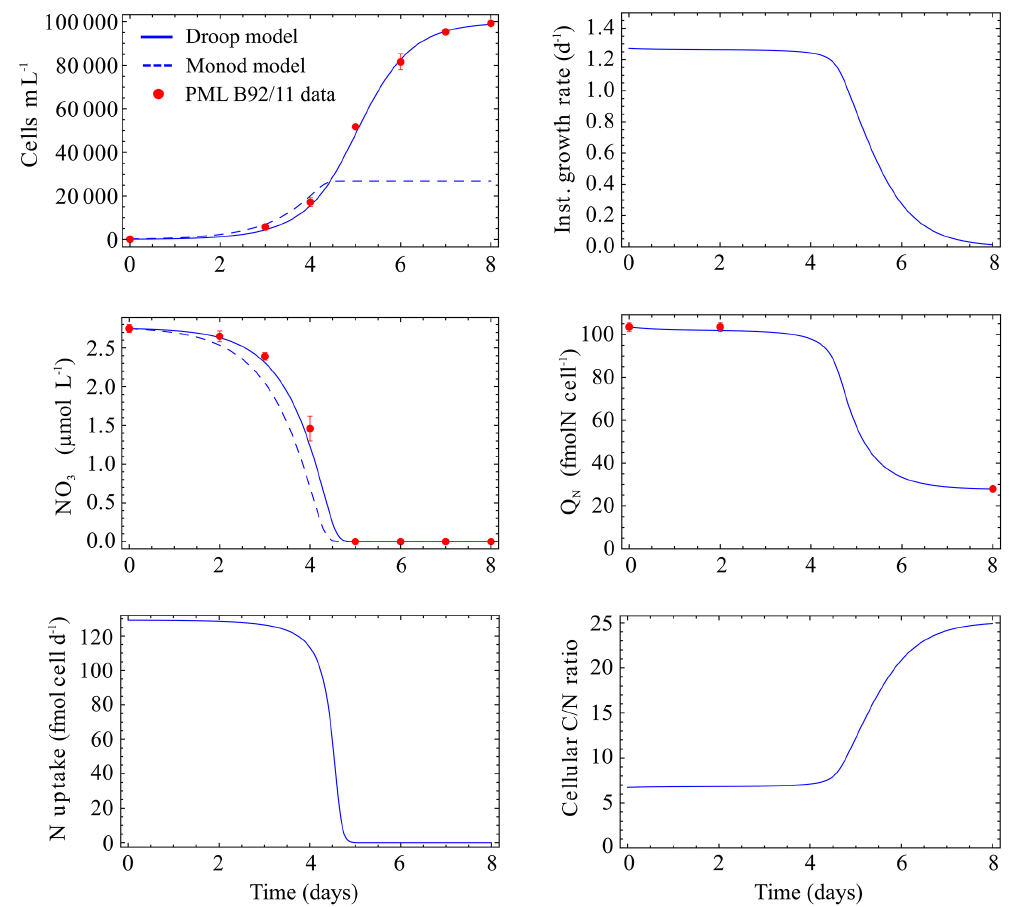
Figure 5. Model fitted to the data of the nitrate-limited cultures of Langer et al. (2013) (Inst =